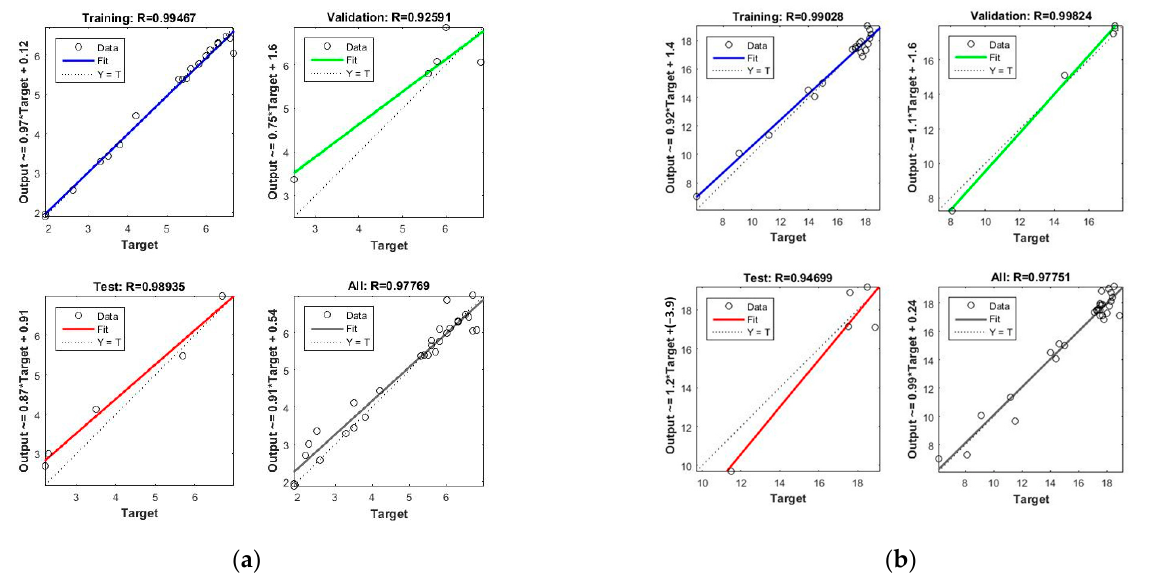
Figure 17. The R-value curves of the ANN structure for ( a ) fuel consumption and ( b ) remaining